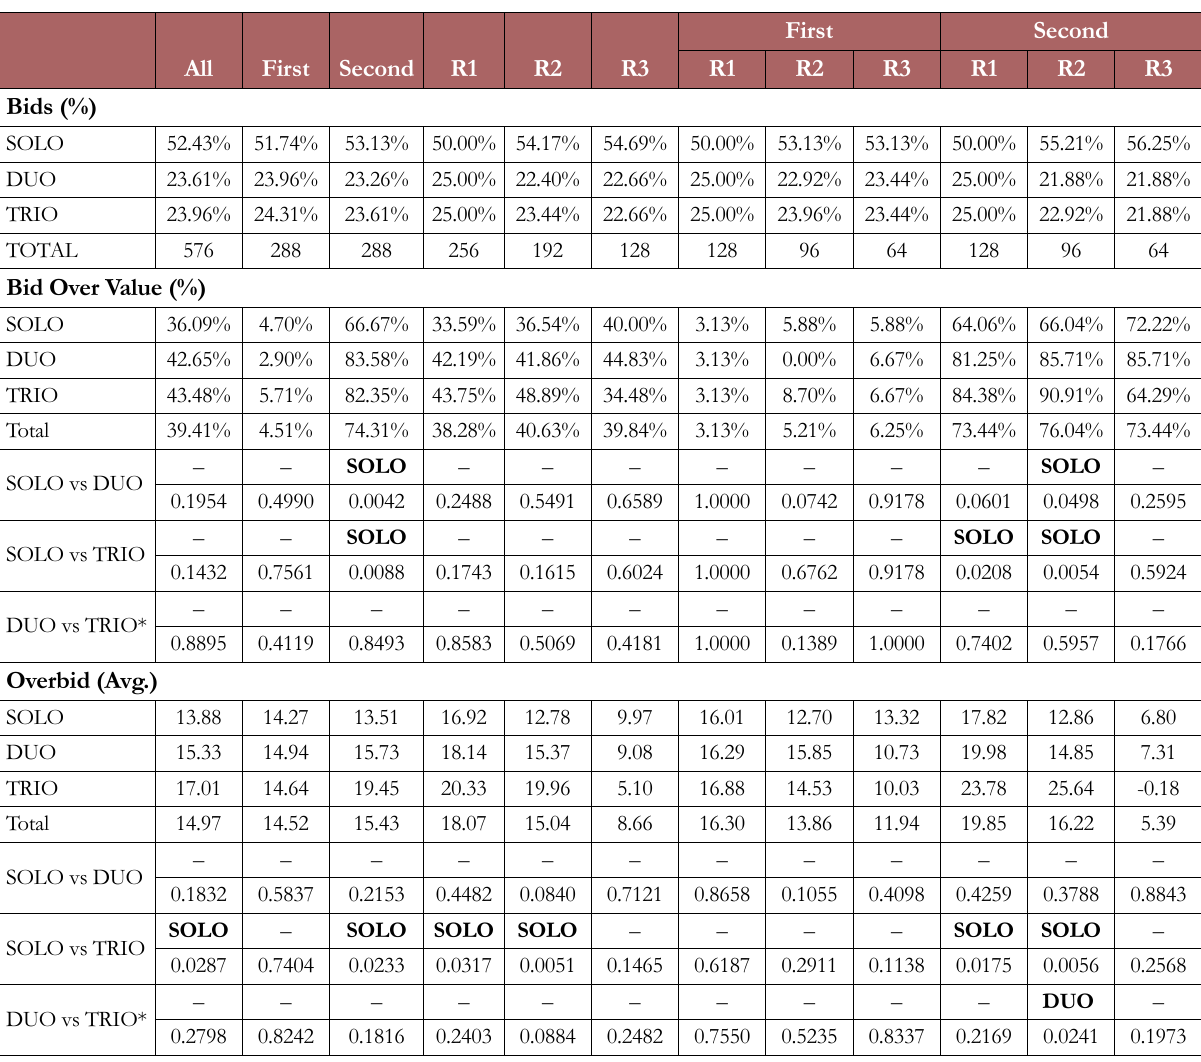
Table A2.1. Experimental game and the bidding behavior: pairwise differences in terms of size by right and